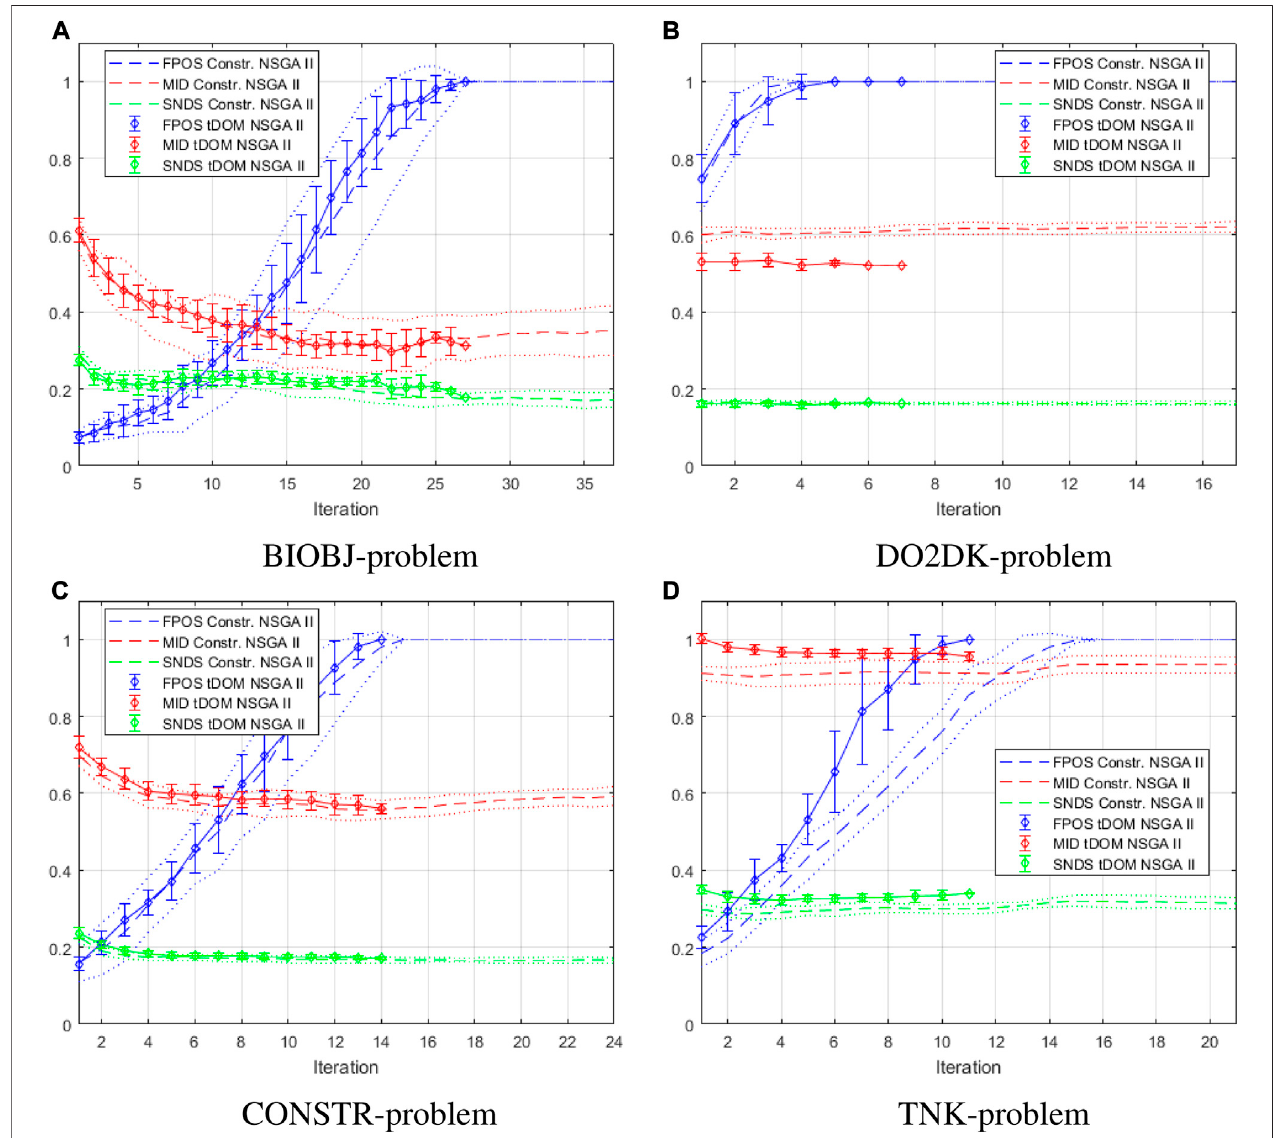
FIGURE 8 | Comparing performance plots of the tDOM-NSGA-II algorithm and the constrained NSGA-II algorithm (average taken over 10 runs) for the BIOBJ- problem (A) , the DO2DK-problem (B) , the CONSTR-problem (C), and the TNK-problem (D) . The iteration axis is cropped.